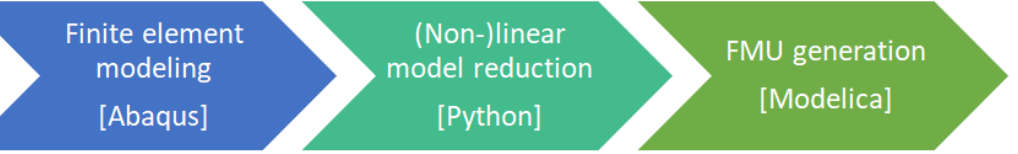
Figure 4. Model reduction workflow (step